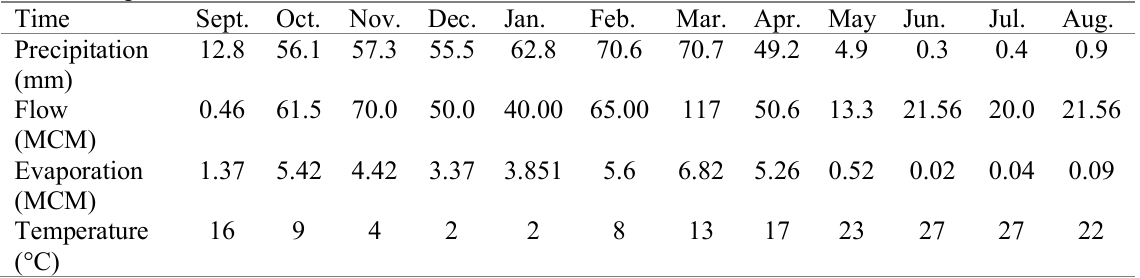
Table 1. Input data and observed flow for the Ilam watershed.